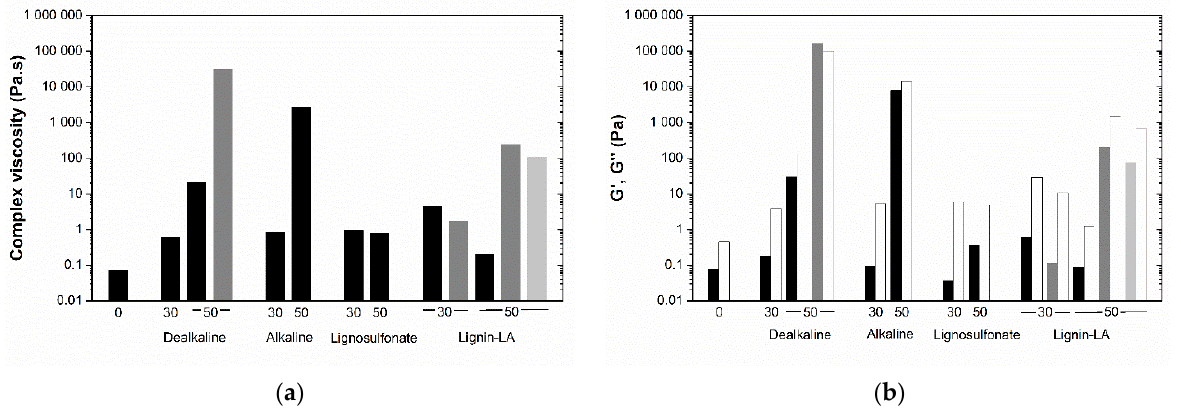
Figure 4. ( a ) Complex viscosity of resins; ( b ) G’ (full bars) and G’’ (empty bars) of resins (5 Pa, 1 Hz, 20 °C) with 0, 30 and 50 wt% of lignin, prepared with 2 wt% (black), 3 wt% (gray), and 4 wt% NaOH (light gray).